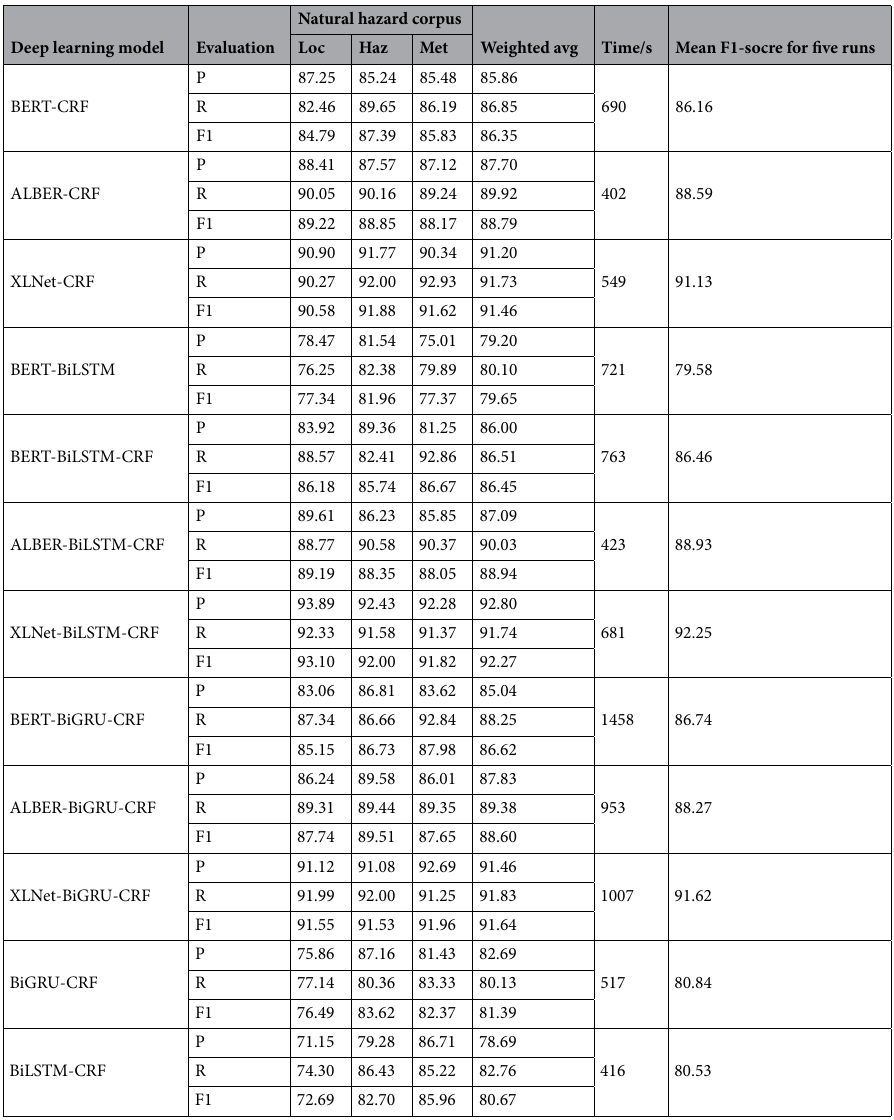
Table 5. Performance of nine deep learning models on natural hazard